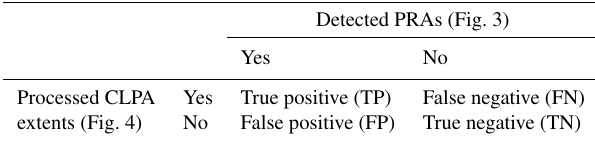
Table 2. Principle of a confusion matrix and application to our PRA detection method.